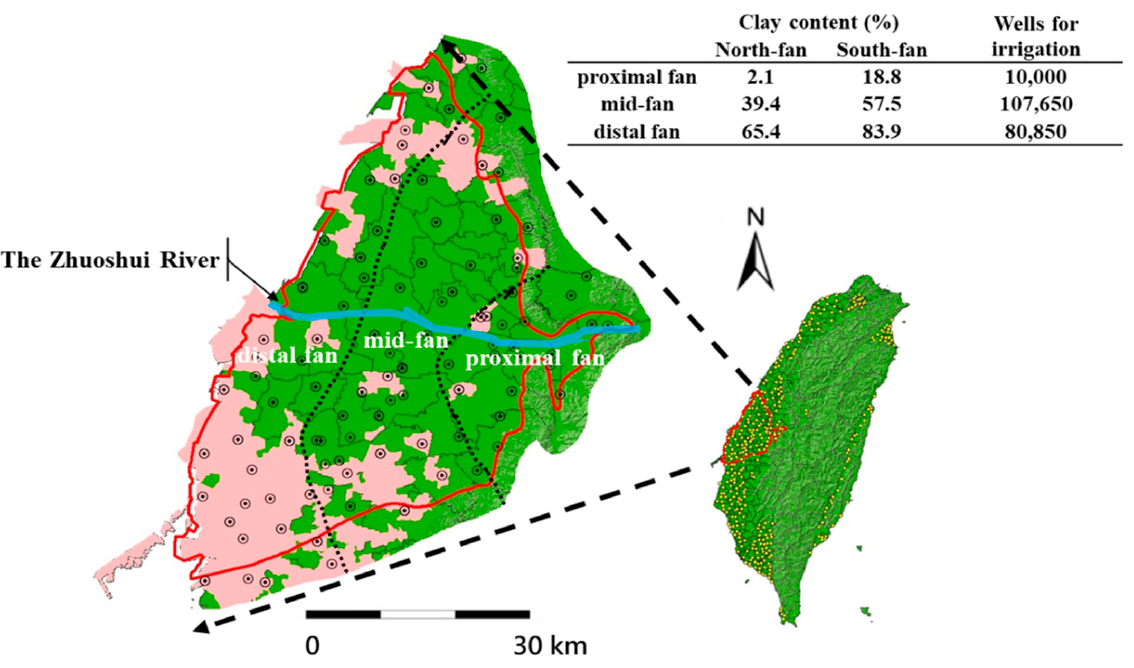
Figure 1. Distribution of the groundwater observation stations in Taiwan and the clay content of the soil and wells for irrigation in the proximal fan, mid-fan, and distal fan in the Zhuoshui River alluvial fan. (Areas with a pink background indicate a potentially arsenic-polluted area of groundwa- ter.).